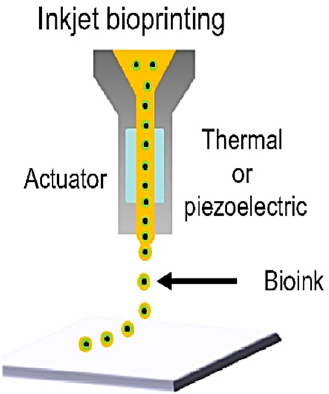
Figure 2. Schematic representation of Inkjet printers ejecting small droplets of cells and hydrogel sequentially to build up tissues. Reprinted with permission from [77].